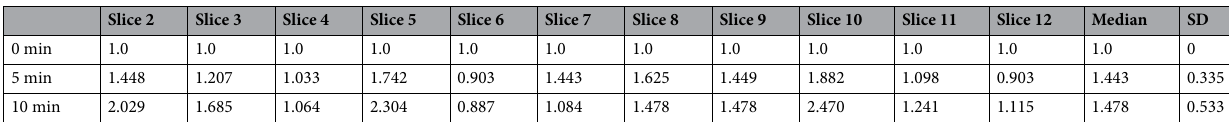
Table 2. Baseline (0 min)-normalized F/P values per unit area below a threshold nanoparticle characteristics. The threshold was kept constant for all the slices. Null hypothesis H0: No observable difference of baseline normalized F/P per unit area between a pair of time instants. The normalized F/P at 0 min is non-normal, whereas KS test fails to reject that the normalized F/P values are sampled from a Normal distribution in cases of 5 min ( P = 0.86) and 10 min ( P = 0.83). H0 is rejected when normalized F/P values are compared at 0 min and 5 min ( P = 0.0077, Wilcoxon rank-sum test) and at (0 min, 10 min) with P = 0.0005 (Wilcoxon rank-sum test). Pairwise T-test fails to reject H0 for (5 min, 10